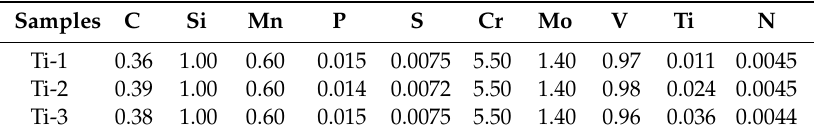
Table 1. Chemical compositions of H13 ingots (wt.%).